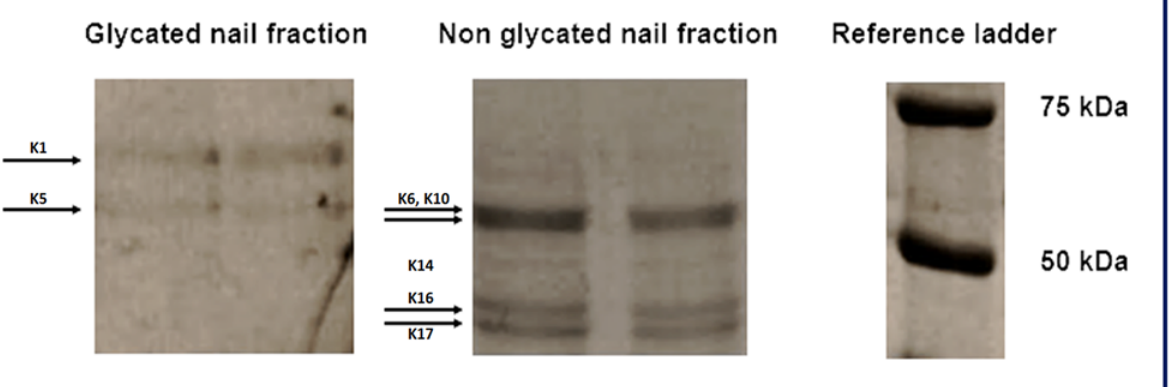
Fig 1. Sodium dodecyl sulfate-polyacrylamide gel electrophoresis (SDS-PAGE) of nail proteins after boronate affinity chromatography (extracted keratins with different molecular mass, ranging from 46 to 67 kDa).